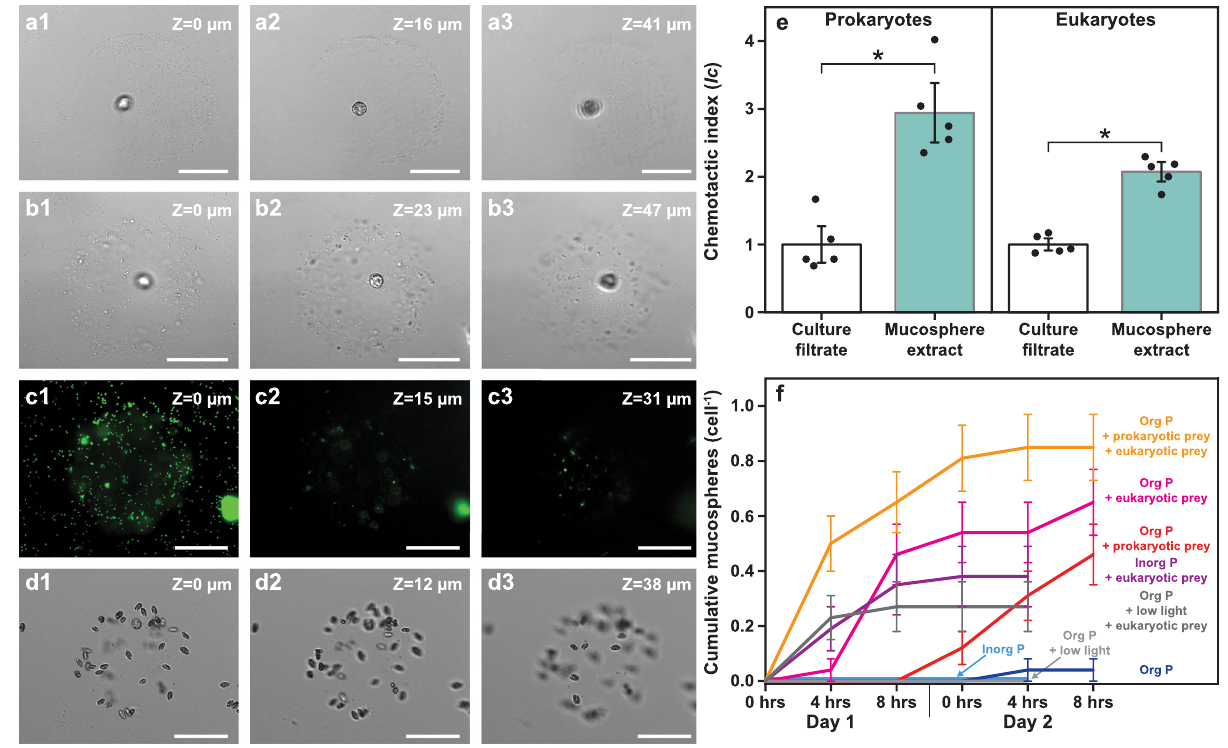
Fig. 3 Detail of mucospheres constructed by Prorocentrum cf. balticum cells to aid prey capture. a – d Three-dimensional structure of the mucospheres with a Z-stack sequence from the (1) bottom, (2) middle and (3) top, with a mucosphere constructed in the absence of prey (axenic culture) ( a ), a mucosphere with captured prokaryotes ( b ), the same mucosphere as in b visualised with the fl uorescent stain SYBR green ( c ), and a mucosphere with captured eukaryotic prey ( R. salina ) ( d ). e Chemotactic response (as Chemotactic Index ( Ic )) of prokaryotic prey (microbiome present in the xenic P . cf. balticum culture) and eukaryotic prey ( R. salina ) to mucosphere derived chemicals. Mean ± standard error ( n = 5 biologically independent samples). Mucosphere-derived chemicals attracted signi fi cantly (*) more prokaryotic and eukaryotic prey than culture fi ltrate controls (two-sided t-test, p = 9.27e − 04 for prokaryotic and p = 4.07e − 05 for eukaryotic prey). f Cumulative mucosphere production in conditions with different resource availability observed at 0, 4, and 8 h after illumination (14:10 light:dark cycle) over two days. The calculated values include when a single P. cf. balticum cell produced multiple mucospheres. Mean ± standard error ( n = 26 cells; Kruskal – Wallis test, p = 4.06e − 12). Images a – d were taken with an Inverted Fluorescence Microscope (Nikon Eclipse Ti), fi tted with a Nikon FITC 480/30 nm ex 535/45nm em fi lter and a monochrome camera (Nikon DS-QiMc) under 200× magni fi cation. Scale bars = 50 µ